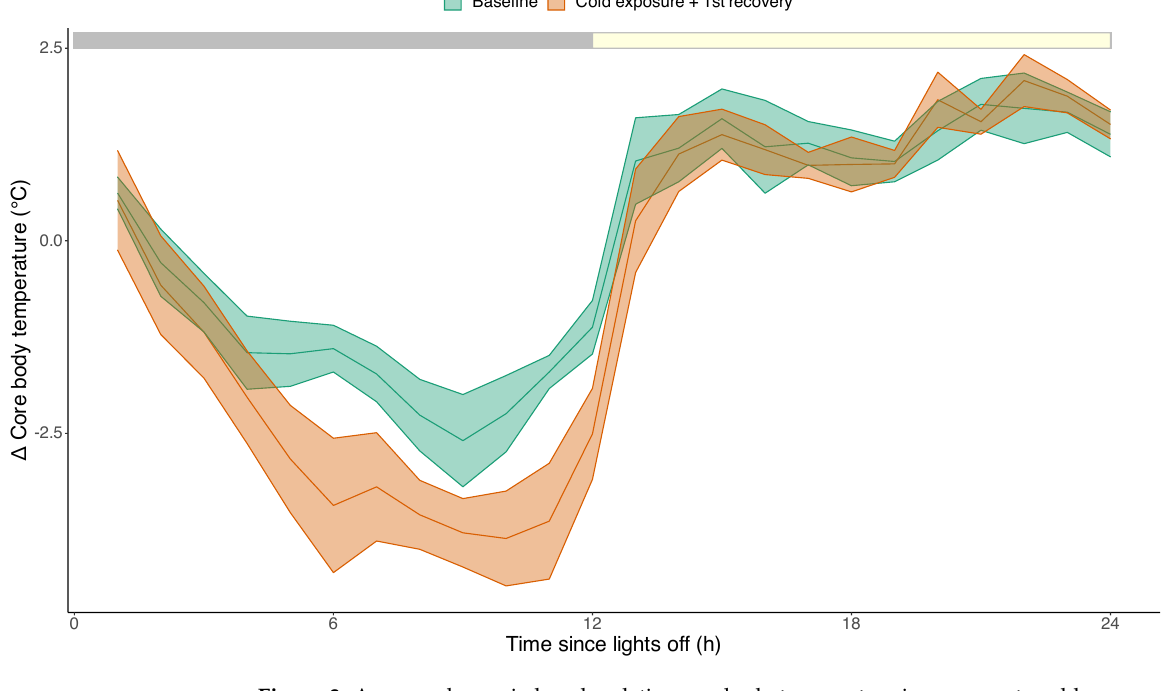
Figure 3. Average change in hourly relative core body temperature in response to cold exposure (n = 6). The red line denotes the baseline condition with ambient temperatures of 24 ◦ C. The blue line denotes nightly cold exposure and the first 12 h of recovery during the light phase, where the ambient temperature was restored to 24 ◦ C. The average response in core body temperature to cold exposure resulted in a total decrease of 1.14 ± 0.7 ◦ C compared to the baseline, especially during the second half of the night, which resulted in a reduction of 1.5 ± 0.8 ◦ C (lm model, p = 0.03). Data are plotted as the average ± SEM (shaded areas around the lines). The grey and yellow bar on top reflects the 12:12 light-dark cycle.